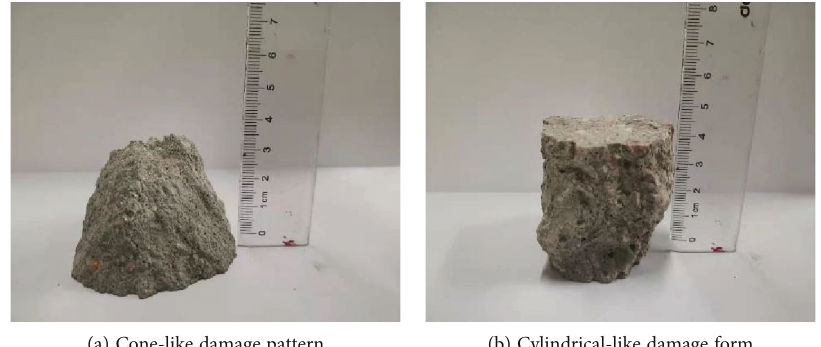
(b) Cylindrical-like damage form Figure 8: Di ff erent concrete fragment destruction patterns. Table 2: Calculation result of unit surface